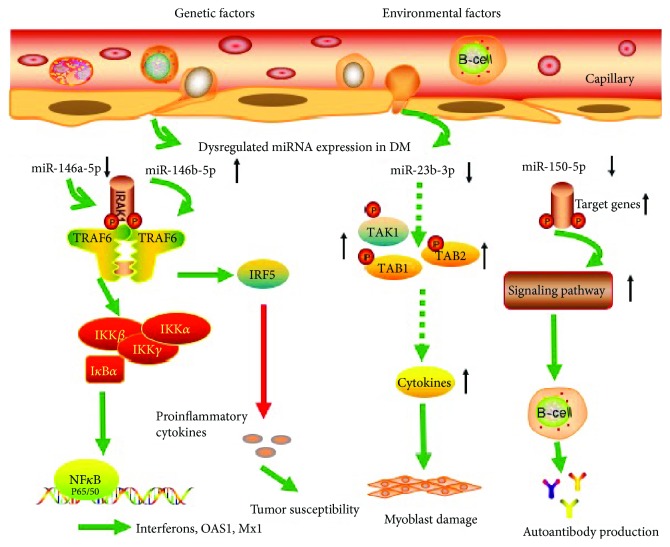
Schematic diagram of the regulation role of four immune-related miRNAs in DM. IRAK1: interleukin-1 receptor-associated kinase 1; TRAF6: tumor necrosis factor receptor-associated factors 6; IKKα: inhibitor kappa B kinase α; IKKβ: inhibitor kappa B kinase β; IKKγ: inhibitor kappa B kinase γ; IkBα: inhibitor k binding α; IRF6: interferon regulatory factor 6; NF-κB: nuclear factor-k-gene binding; TAK1: transforming growth factor-activated kinase-1; TAB1: transforming growth factor-beta-activated protein kinase 1-binding protein 1; TAB2: transforming growth factor-beta-activated protein kinase 1-binding protein 1; TAK1: transforming growth factor-β-activated kinase 1.